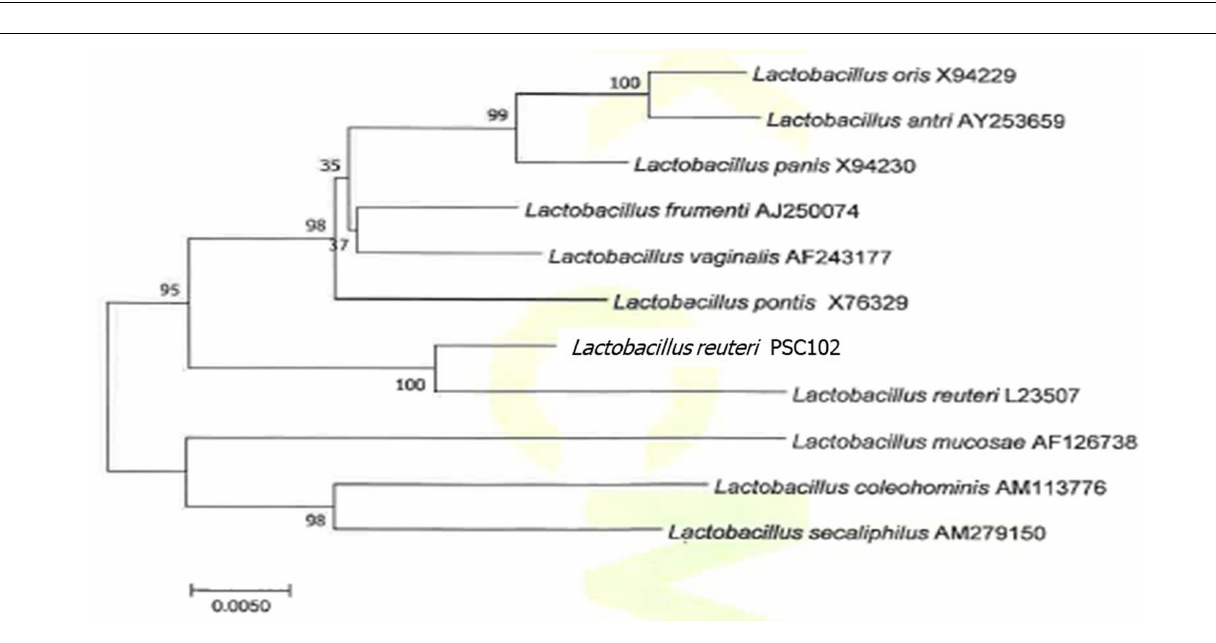
FIGURE 2 | Morphology of control L. reuteri PSC102 (A) and hLR (B) .